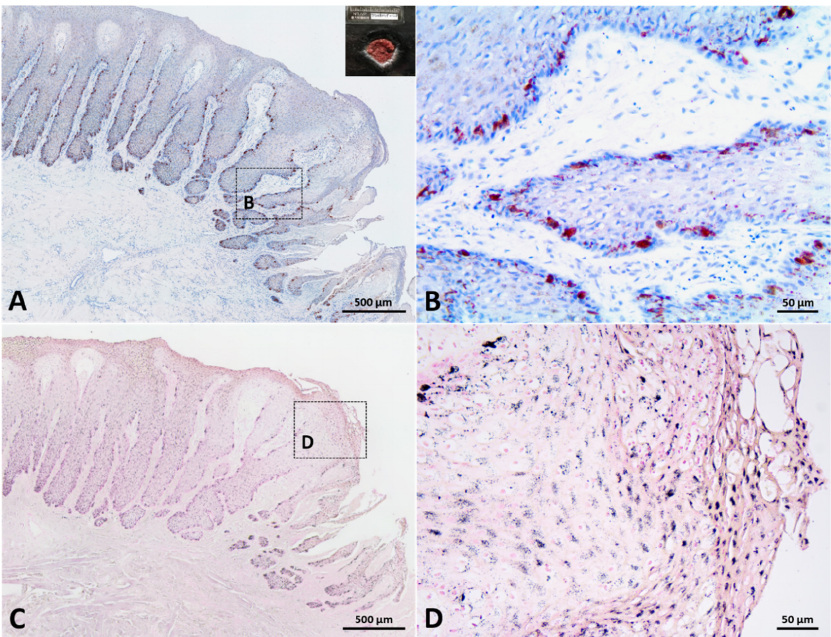
Figure 3. The distribution of melanocytes and melanin in a stage 3 wound collected from dark skin region. ( A , B ): Immunohistochemical staining with cocktail antibody. Numerous melanocytes were observed in the basal layer of neoepidermis, including leading edge of migrating epithelial tongue. ( C , D ): Fontana–Masson staining. Abundant melanin granules were distributed throughout the neoepidermis, including the stratum externum of leading edge of migrating epithelial tongue.